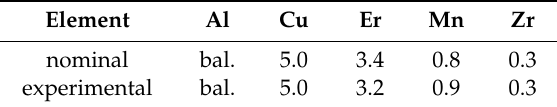
Table 1. Chemical composition of the alloy, wt %.